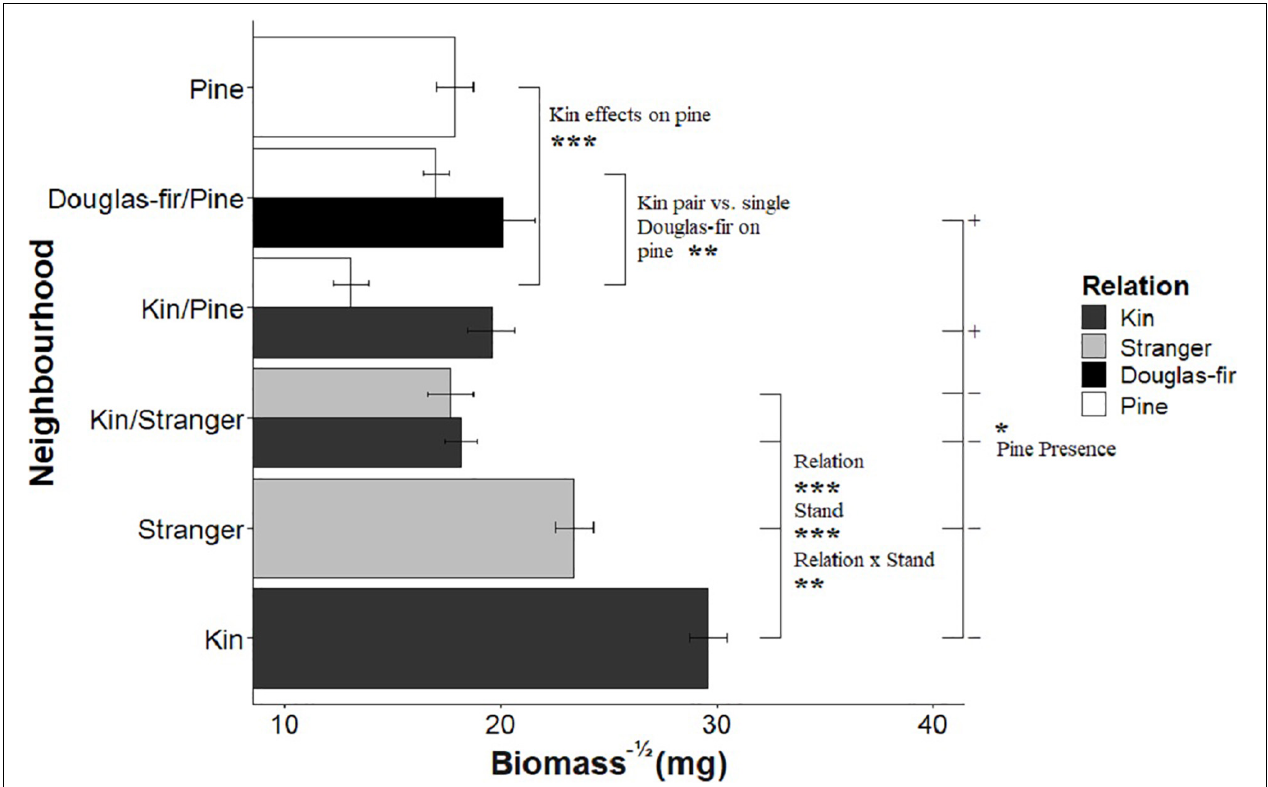
FIGURE 2 | The effect of neighborhood treatments on the square-root of biomass for Douglas-fir seedlings (shaded) and pine seedlings (white). Significant planned contrasts are shown. Relation contrasted kin with stranger seedlings (estimate = –6.68, t ratio = –3.76, p = 0.0002, Df = 206). Stand contrasted seedlings grown in pure stand with those in mixed stands (estimate = 17.2, t ratio = 9.67, p < 0.0001, Df = 206). Relation × stand interaction was also significant (estimate = –5.73, t ratio = –3.22, p = 0.0015, Df = 206). The pine presence contrasted Douglas-fir seedlings grown with a pine neighbor vs. without a pine present in the pot (estimate = –4.77, t ratio = –2.33, p = 0.0207, Df = 206). Pine seedlings grown with a pair of kin had less biomass than those grown in pairs of pine with a single Douglas-fir and less than pine grown in pure pine stands. * p < 0.05, ** p < 0.01, and *** p <